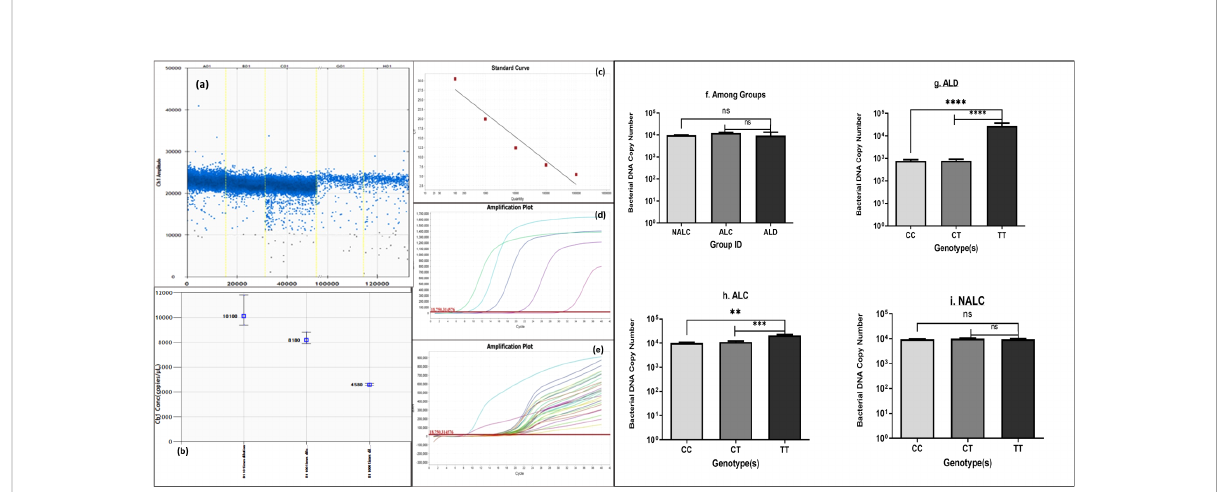
FIGURE 5 Bacterial DNA copy number (A, B) generated by ddPCR, (C – E) of each individual calculated from standard curve generated by real-time PCR, (F) of the three groups and (G – I) of genotypes CC/CT/TT of ALD, ALC, and NALC groups respectively. Signi fi cant differences p >0.05 was observed for ALD and ALC group represented with * in the scale. **p value =0.001, ***p value =0.0001, ****p value =0.00001, ns, not signi fi